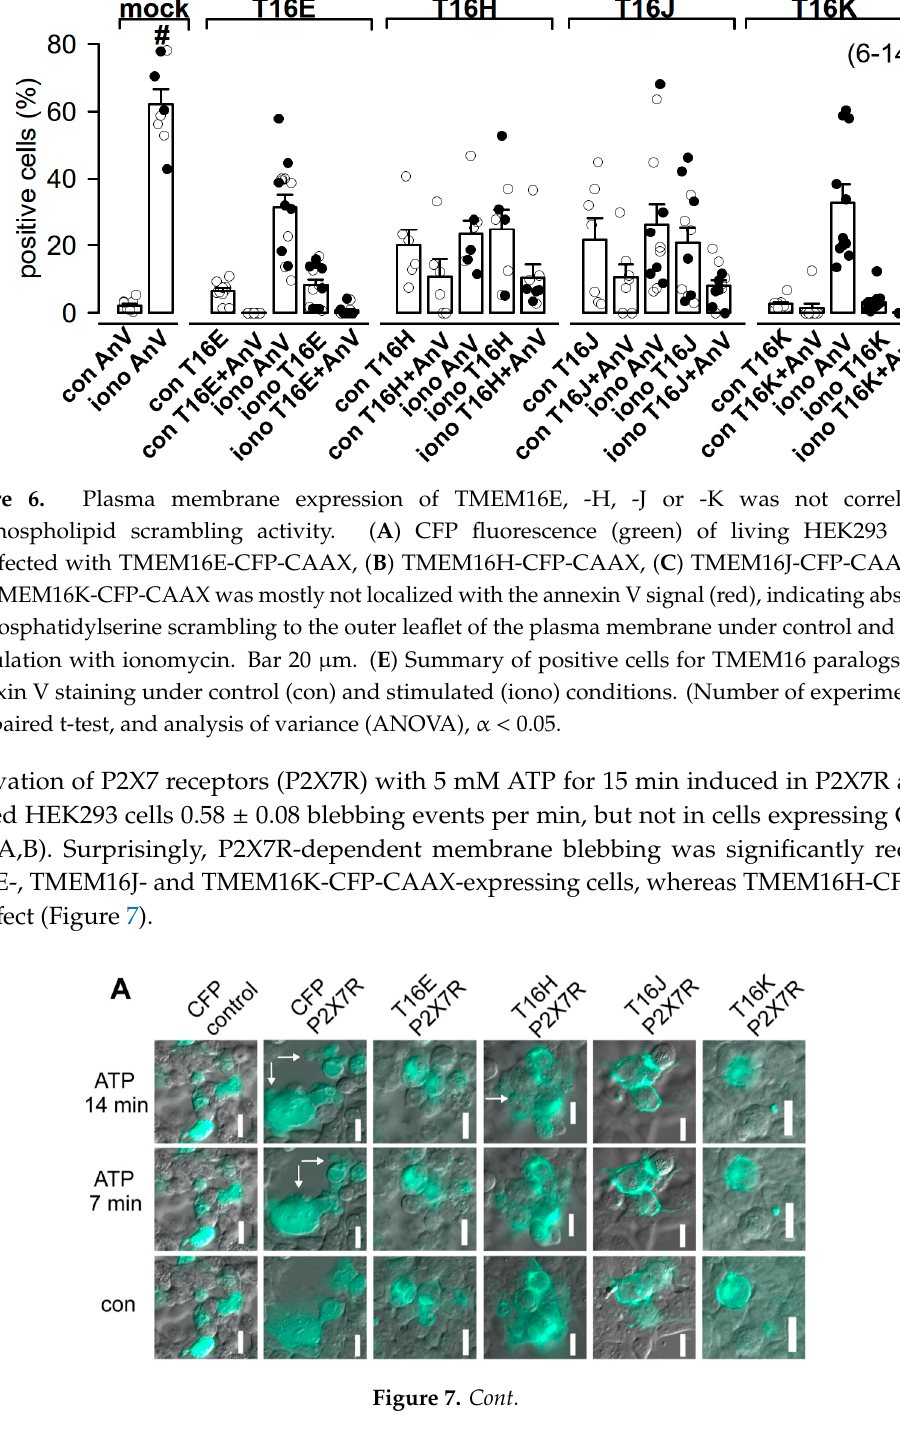
Figure 6. Plasma membrane expression of TMEM16E, -H, -J or -K was not correlated to phospholipid scrambling activity. ( A ) CFP fluorescence (green) of living HEK293 cells transfected with TMEM16E- CFP-CAAX, ( B ) TMEM16H-CFP-CAAX, ( C ) TMEM16J-CFP-CAAX or ( D ) TMEM16K-CFP-CAAX was mostly not localized with the annexin V signal (red), indicating absence of phosphatidylserine scrambling to the outer leaflet of the plasma membrane under control and after stimulation with ionomycin. Bar 20 µm. ( E ) Summary of positive cells for TMEM16 paralogs and annexin V staining under control (con) and stimulated (iono) conditions. (Number of experiments), # unpaired t-test, and analysis of variance (ANOVA), α < 0.05.